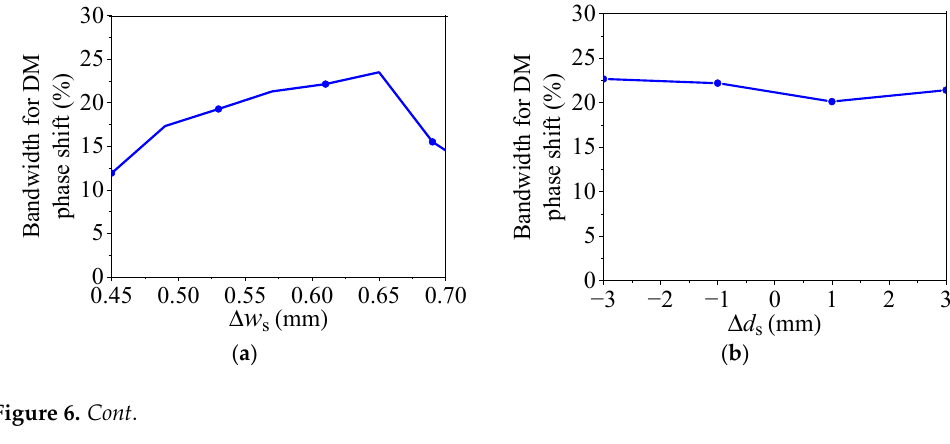
Figure 5. The simulated bandwidth for 15-dB DM impedance matching of the proposed balanced SIW phase shifter with different w s , d s , l s , and l f . ( a ) With different w s . ( b ) With different d s . ( c ) With different l s . ( d ) With different l f .